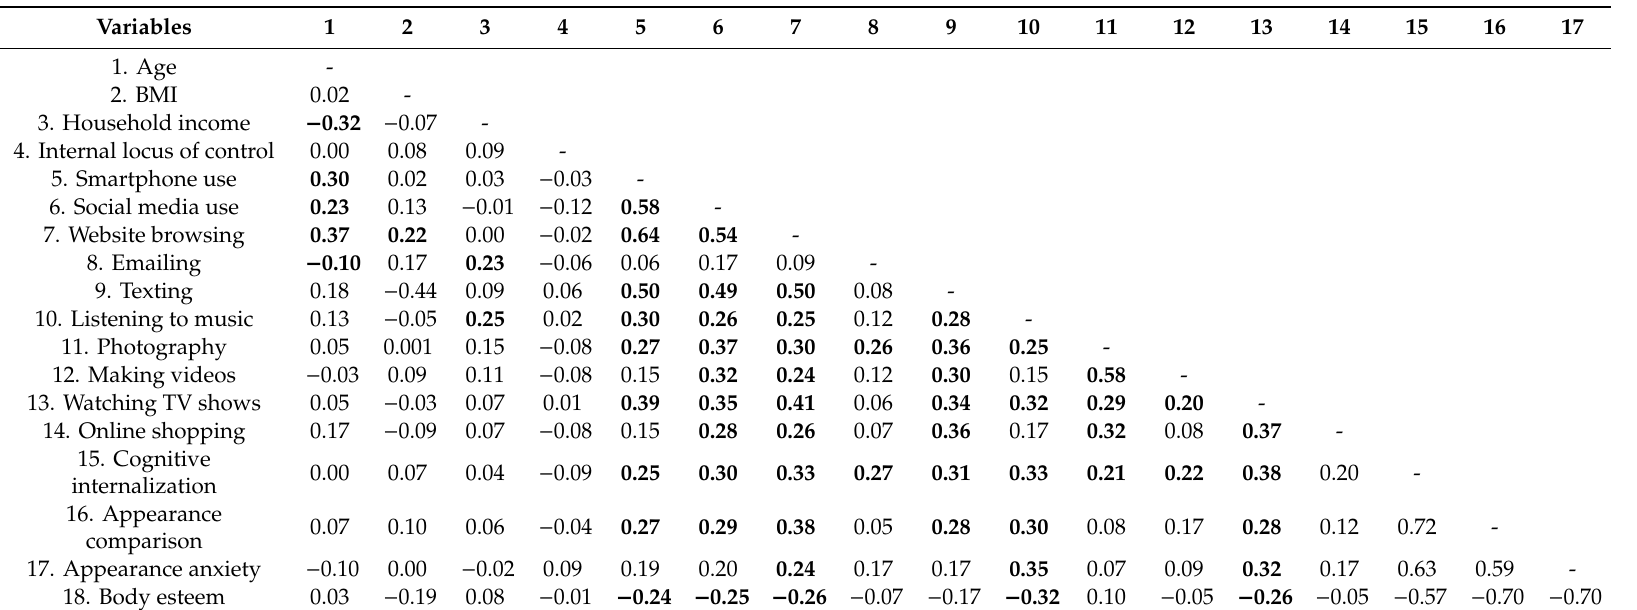
Table A1. Zero-order Correlations between Predictor, Covariates, Mediators, and Criterion Variables.